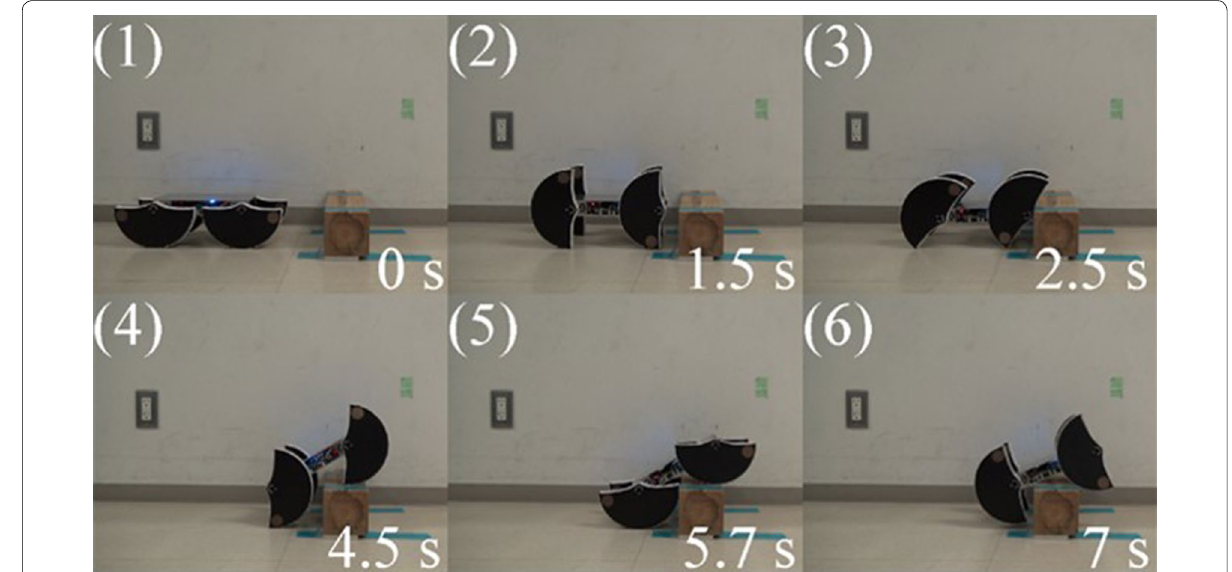
which all four wheels are in contact with the ground. In the areas of green and orange, the prototype model is in a state in which it does not overturn. As a result of per- forming calculations of one circle of crawl gait from the Eq. (1), CoG coordinates were found to be in the stable region in all conditions. Also, it is possible for the pro- totype to move without falling. At this time, the moving distance of the center of gravity is 10 mm. ± m ( Rf + Rr + Lf + Lr ) (1) G = 4 The vertical axis represents the center of gravity coor- dinates of the prototype model with respect tothe X axis, and the horizontal axis represents time. Areas of